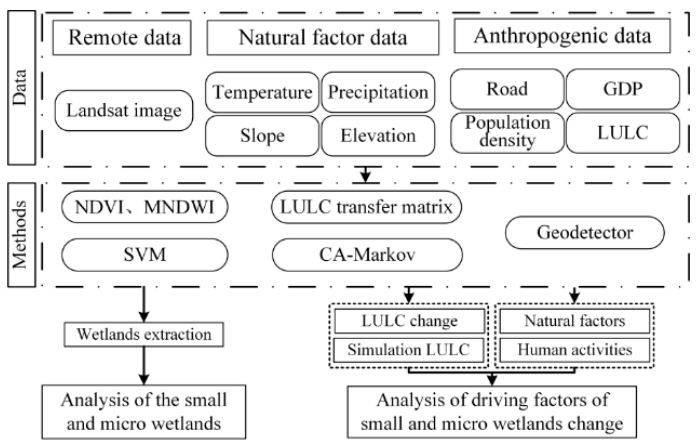
Figure 2. Methodology framework of this